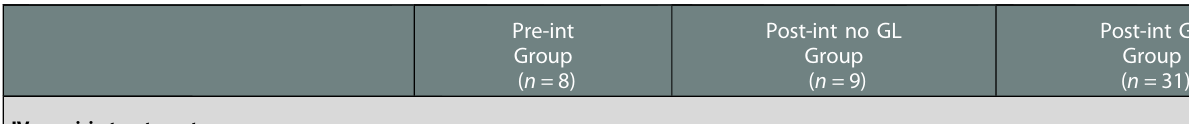
TABLE 3 Antibiotics used in the different groups - OM.